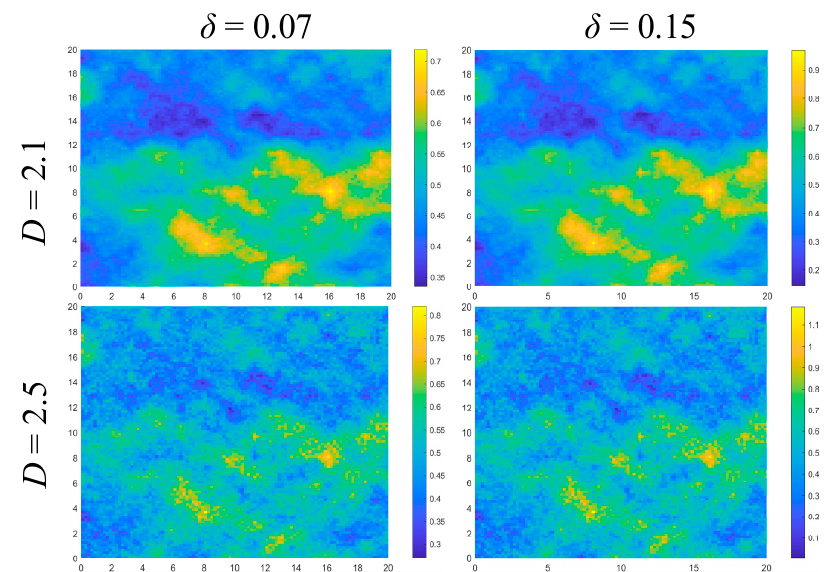
Figure 3. The aperture distribution of rough-walled fractures.